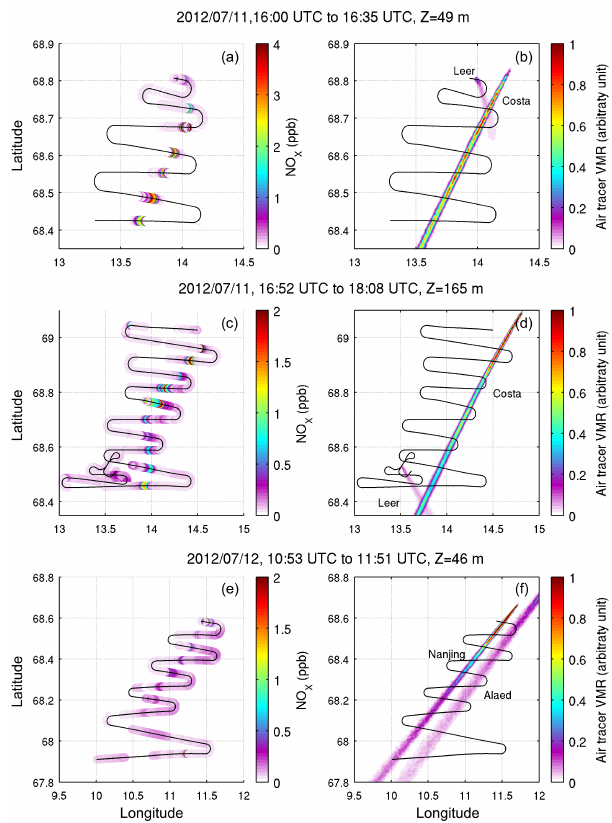
Figure 3. Left panels: ACCESS airborne NO x measurements be- tween (a) 16:00 and 16:35UTC, 11 July 2012 (flight leg at Z ∼ 49m), (c) 16:52 and 18:08UTC, 11 July 2012 ( Z ∼ 165m), and (e) 10:53 and 11:51UTC, 12 July 2012 ( Z ∼ 46m). Right panels: corresponding FLEXPART-WRF plumes (relative air tracer mix- ing ratios): (b, d) Wilson Leer and Costa Deliziosa plumes and (f) Wilson Nanjing and Alaed plumes. FLEXPART-WRF plumes are shown for the closest model time step and vertical